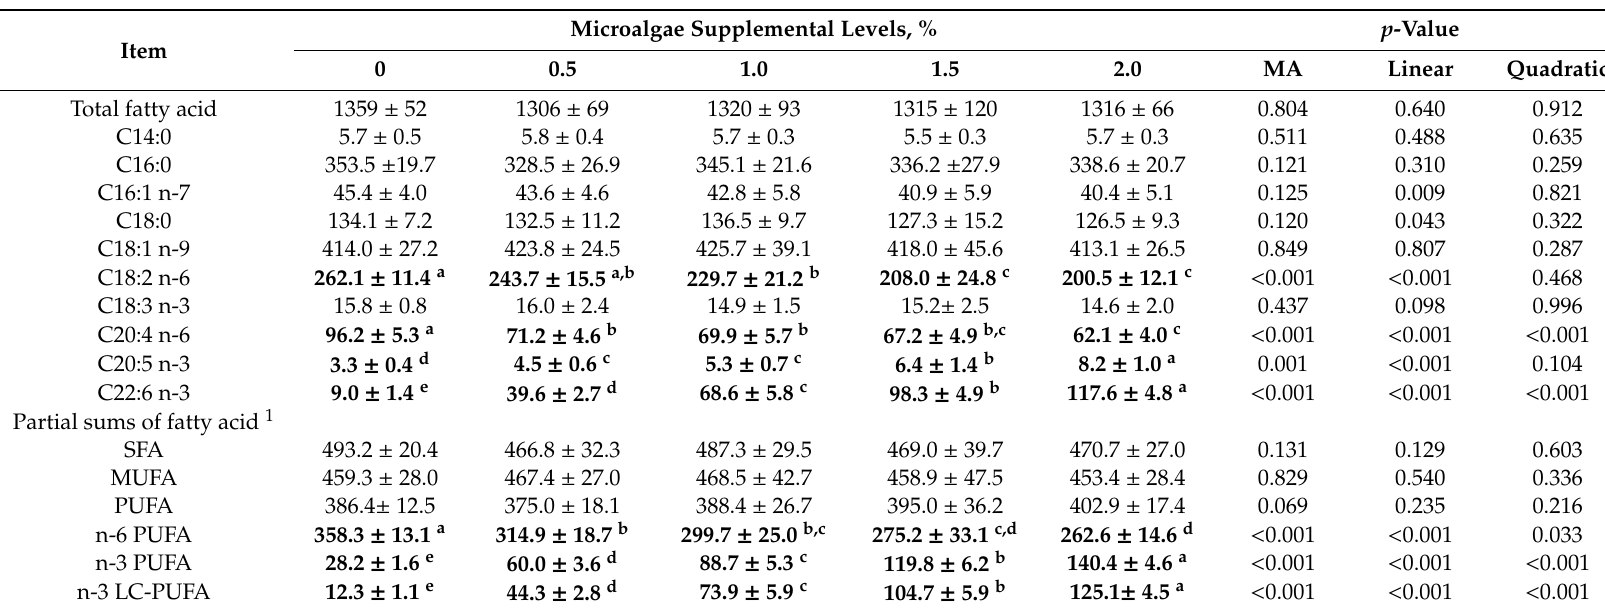
Table 3. Fatty acid content (mg / 100 g fresh meat) of breast muscle from laying hens with graded levels of Aurantiochytrium sp.